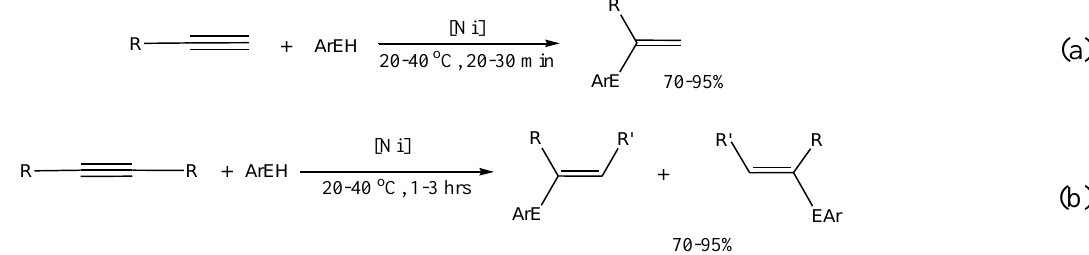
Figure 10. Dependence of yield of the reaction on the size and morphology of catalytic particles [M(SAr) ] derived from different precursors MX 2 n